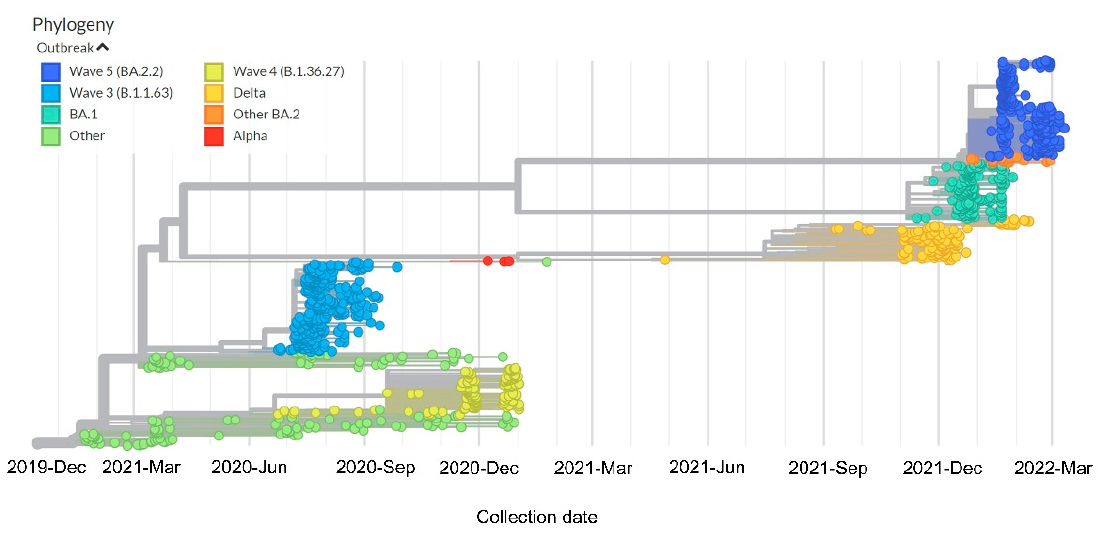
Figure 4. Time-resolved phylogenetic tree of 1168 viral genomes from January 2020 to March 2022 in Hong Kong. The tree was constructed using the Nextstrain command-line interface. The color of the dots represents the outbreak wave of a particular strain. The branch length was determined by the collection date of a sample. Wuhan-Hu-1 was used as the reference sequence during the tree construction.